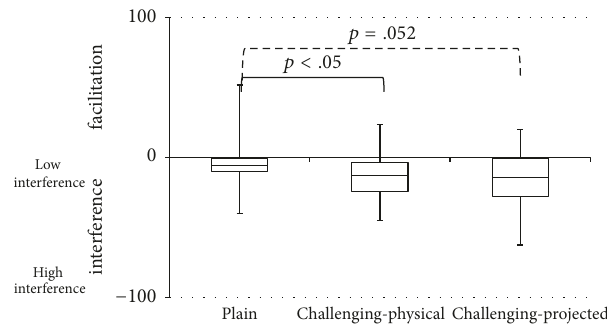
Figure 2: Boxplots of cognitive-motor interference scores for the plain walking environment and the two challenging walking environments with either stationary physical context (challenging- physical) or suddenly appearing projector-augmented context (challenging-projected). Negative values indicate poorer dual-task than single-task performance (i.e., cognitive-motor interference). One extreme outlier (223% in challenging-projected) was omitted from the figure. Significant effects ( 𝑝 < .05 ) are represented by solid lines and tendencies ( .05 < 𝑝 < .075 ) are represented by dashed